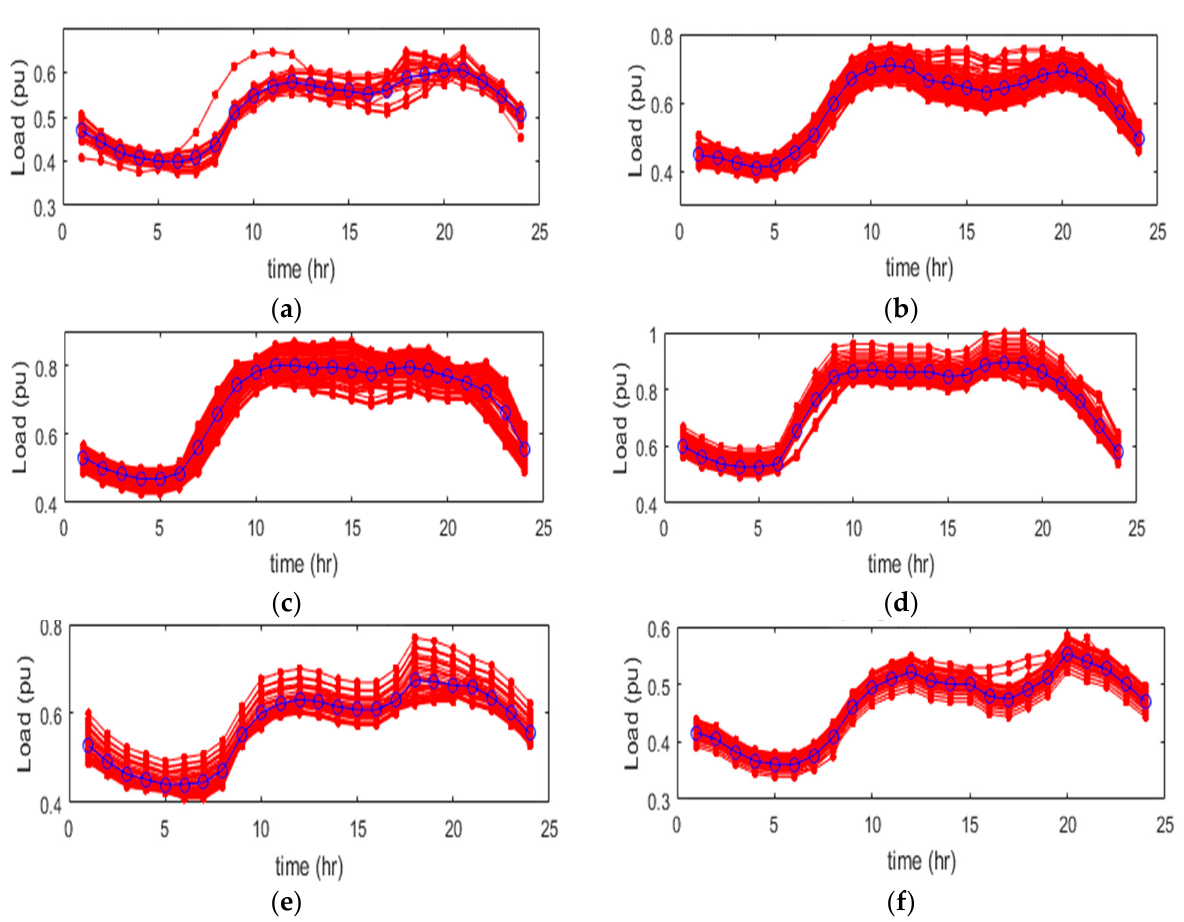
Figure 2. The cluster of load demand curves and the associated representative centroids for ( a ) summer weekdays; ( b ) summer weekends; ( c ) winter weekdays; ( d ) winter weekends; ( e ) spring/fall weekdays; ( f ) spring/fall weekdays. Table 2. Clusters’ representative centroids.